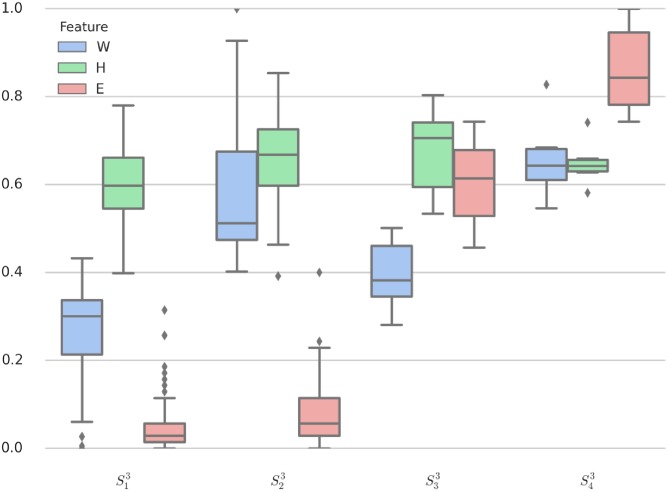
Box-plot of 3-dim clustering data.